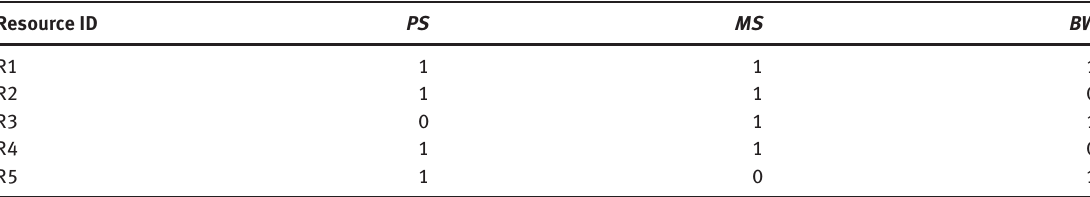
Table 2: Resource Capability